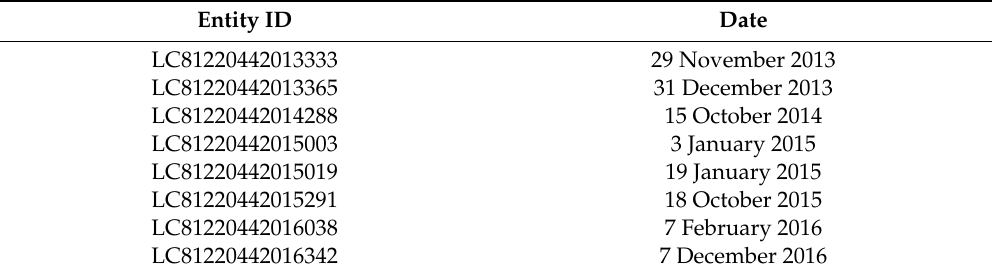
Table 1. Landsat 8 images of Guangzhou for the local climate zone (LCZ)